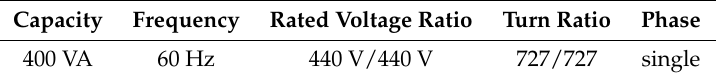
Table 1. Transformer [21]